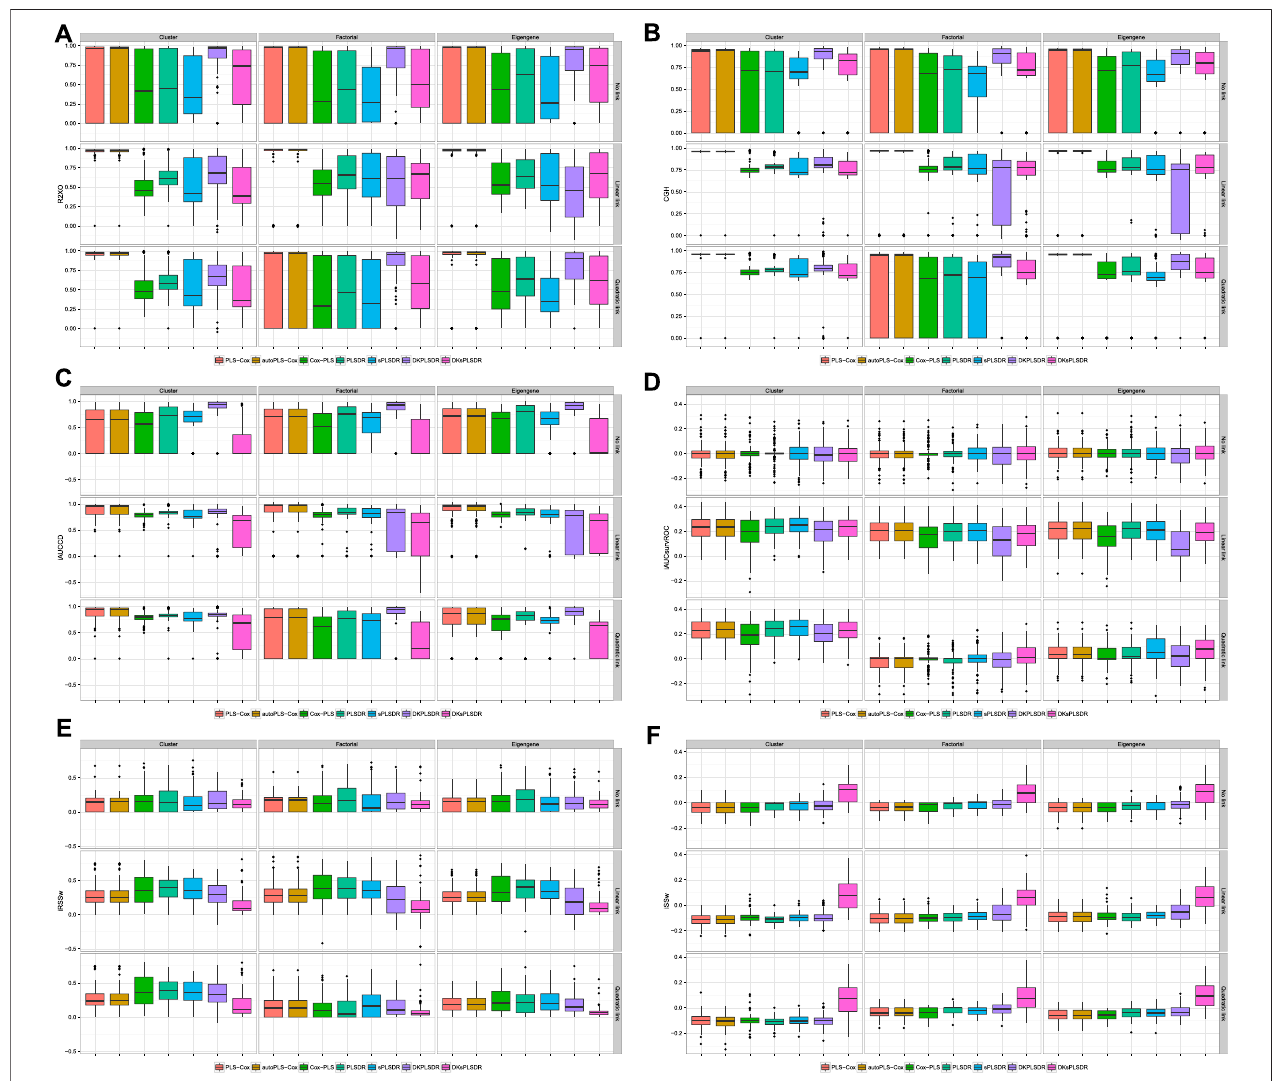
FIGURE 5 | Δ (iAUCUno CV − vHCVLL), panel by measure. panel (A) : R2XO measure. panel (B) : GHCI measure. panel (C) : iAUCCD measure. panel (D) : iAUCSurvROC measure. panel (E) : iRSSw measure. panel (F) : iSSw measure.